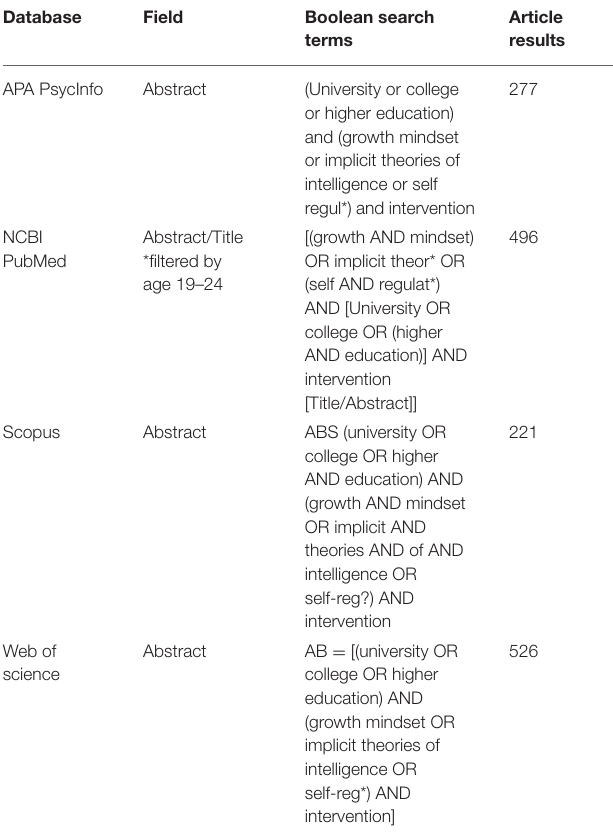
TABLE 1 | Search terms used in article search across four